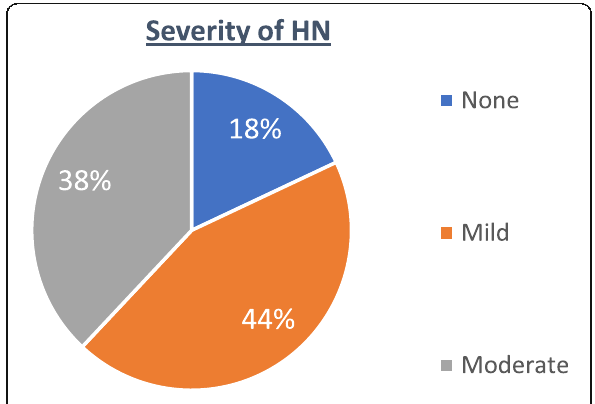
Fig. 1 Severity of HN in the